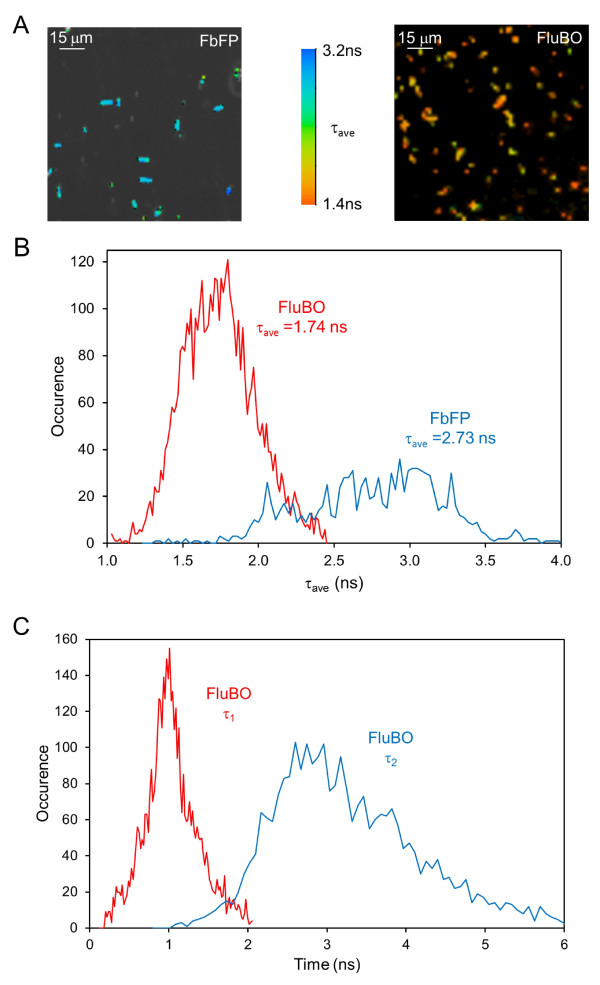
In vivo analysis of FluBO fluorescence lifetime. (A) FLIM pictures of E. coli cells expressing either FbFP or FluBO. Cells were cultivated until they reached the stationary growth phase. Fluorescence was observed at the maximum of FbFP (λobs < 500 nm; λexc = 760 nm). Two-photon excitation of FluBO fluorescence was tested at different wavelengths and was found best at 760 nm, corresponding the doubled wavelength of the normal one-photon excitation optimum (380 nm, see Figure 1D). The figure shows the fluorescence lifetimes (τave) of FbFP (left panel) and FluBO (right panel) in living E. coli cells. (B, C) Analysis of the fluorescence decays of FluBO and FbFP expressed in E. coli under aerobic conditions (data are derived from images shown in Figure 2A). The fluorescence decay of FbFP was satisfactorily analyzed with a monoexponential decay function (F(t) = a·exp(-τ1/t); τave = τ = 2.73 ns) while the fluorescence decay of FluBO needed a biexponential decay for correct description (F(t) = a1·exp(-τ1/t)+ a2·exp(-τ2/t); τave = (a1·τ1+a2·τ2)/(a1+a2) = 1.74 ns); τ1 = 1.03 ns, τ2 = 2.72 ns. Due to FRET, the average fluorescence lifetime τave of FbFP in FluBO is reduced by 0.99 ns compared to FbFP alone. Using the average lifetimes of FbFP and FluBO and the equation E = 1-τave, FluBO/τave, FbFP an apparent FRET efficiency of 37% is calculated (B). The shorter lifetime (mean τ1 = 1.03 ns) determined form detailed analysis of the FluBO-FLIM experiments exhibited a major amplitude of 67%. Hence, a FRET efficiency of approximately 62% within the FluBO proteins that undergo FRET can be deduced from τ1 (E = 1-τ1/τave, FbFP). The remaining 33% of FluBO molecules behave like single isolated FbFP molecules with a long lifetime of 2.72 ns (C).